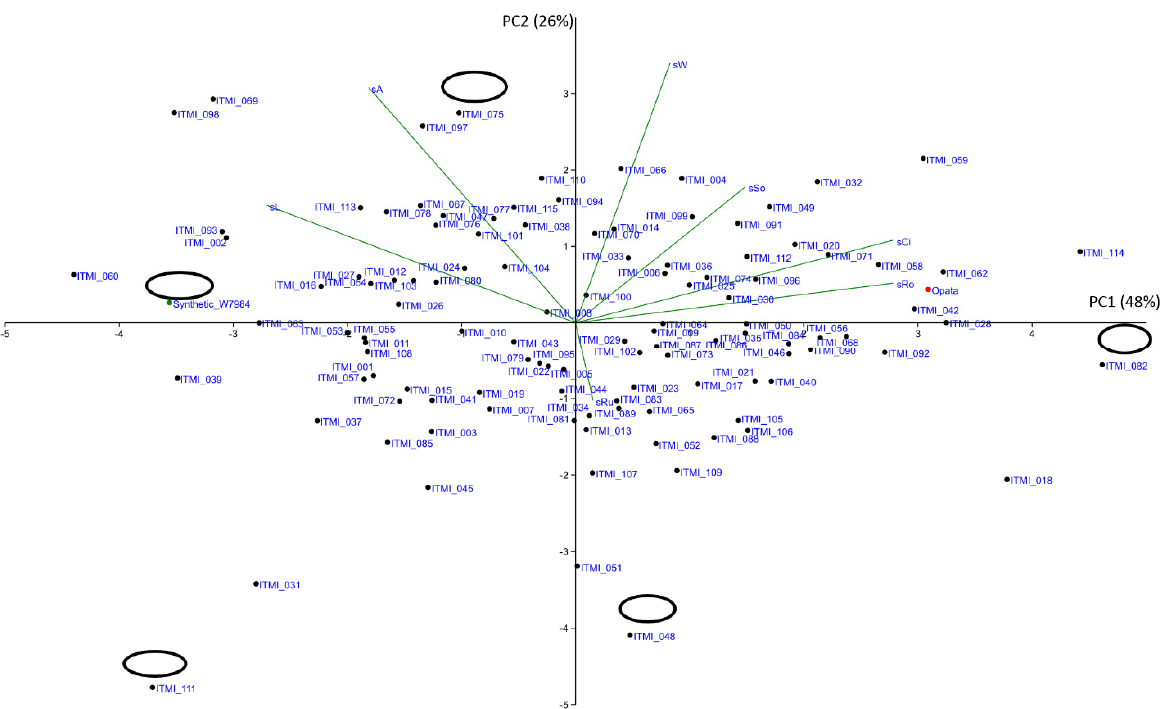
Figure 2. PCA biplot of seed size and shape of ITMI/MP performed using seed 7 coat traits. Ellipses represent seed size and shape for some contrast genotypes in the same scale. Parent genotypes are shown by green (Synthetic_W7984) and red (Opata) dots. PC1, PC2 axes denote principal components 1 and 2, percentage of variance explained shown in parentheses.